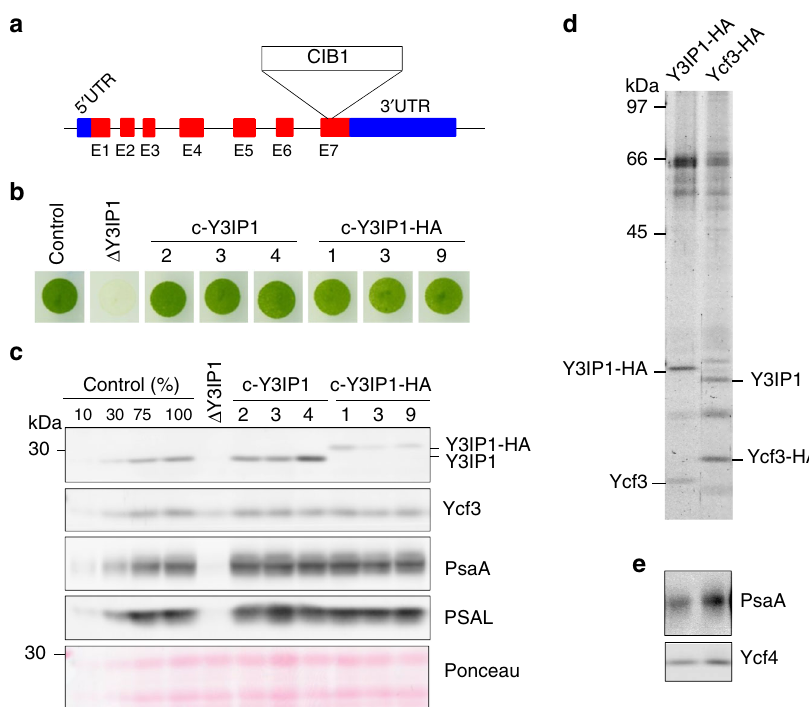
Fig. 3 Af fi nity puri fi cation of Y3IP1-HA. a Δ Y3IP1/CGL59 mutant (LMJ.RY0402.195677) from the CLiP contains the paromomycin resistance cassette (CIB1) inserted at the 7th Exon (E7) of CGL59/Y3IP1 (Cre06.g280650). Exons, introns, and untranslated regions are shown as red boxes, black lines, and blue boxes, respectively. This strain also contains second CIB1 cassette in CAH2 locus (Cre04.g223050). The mutant was complemented with cDNA of Y3IP1 (c-Y3IP1) or Y3IP1-HA (c-Y3IP1-HA). b The growth of CLiP host strain as control, Δ Y3IP1, and three c-Y3IP1 clones (2, 3, and 4) and c-Y3IP1-HA clones (1,3, and 9), under the photoautotrophic condition in the light of 50 μ mol photons m − 2 s − 1 . c Total cell proteins from control, Δ Y3IP1, c-Y3IP1, and c-Y3IP1-HA strains were analyzed by immunoblotting using antibodies against Y3IP1, Ycf3, PsaA, and PSAL. The nitrocellulose membrane was stained with Ponceau for loading control. d The polypeptide composition of the af fi nity-puri fi ed Y3IP1-HA and Ycf3-HA. Polypeptides separated by SDS-PAGE were visualized by staining with Flamingo. e Immunoblotting of the puri fi ed Y3IP1-HA and Ycf3-HA with antibodies against PsaA and Ycf4 NATURE COMMUNICATIONS| (2018) 9:2439 |DOI: